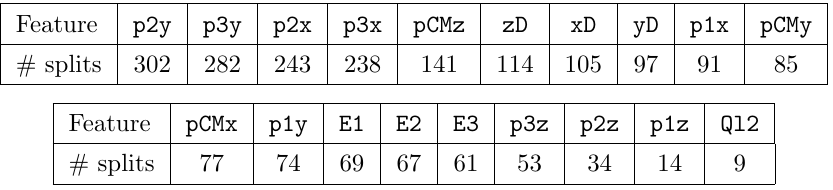
Table 2. Feature importance for a 1 GeV HNL coupling to (cid:22)